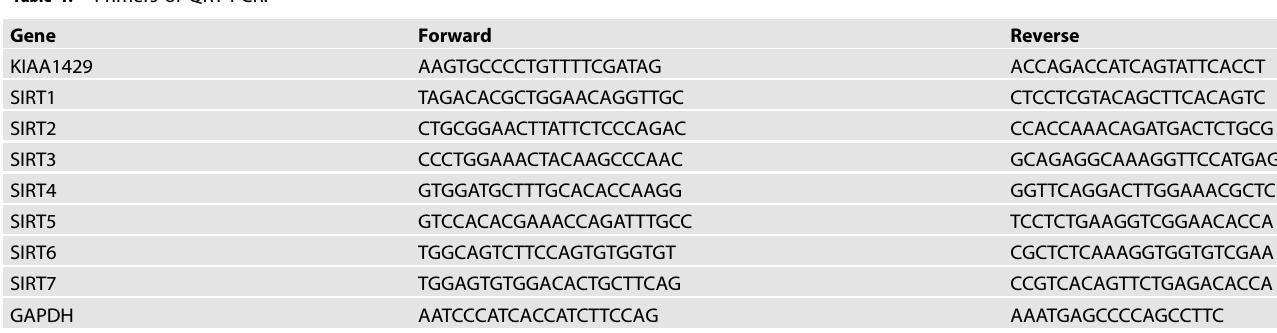
Table 1. Primers of